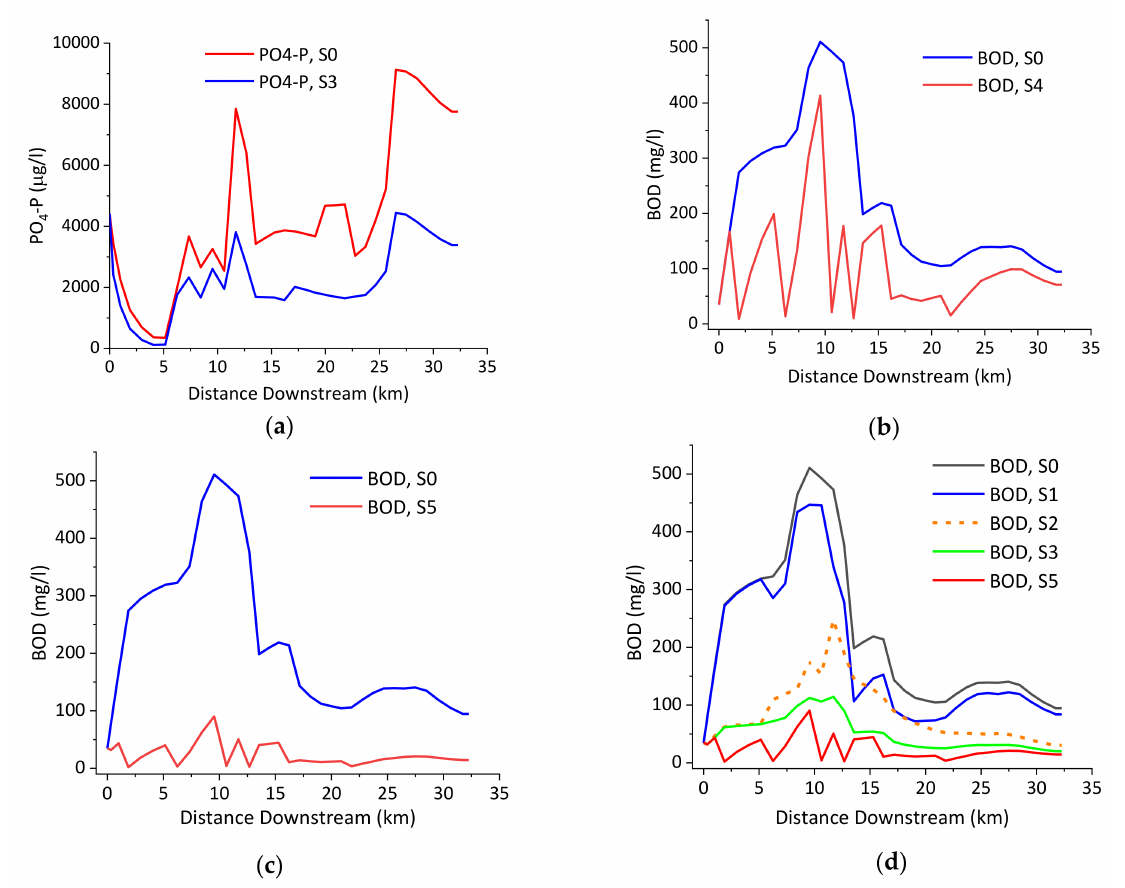
Figure 7. Evaluation of S3, S4, and S5 for BOD ( a – c ) and PO 4 -P ( d ) relative to the base scenario